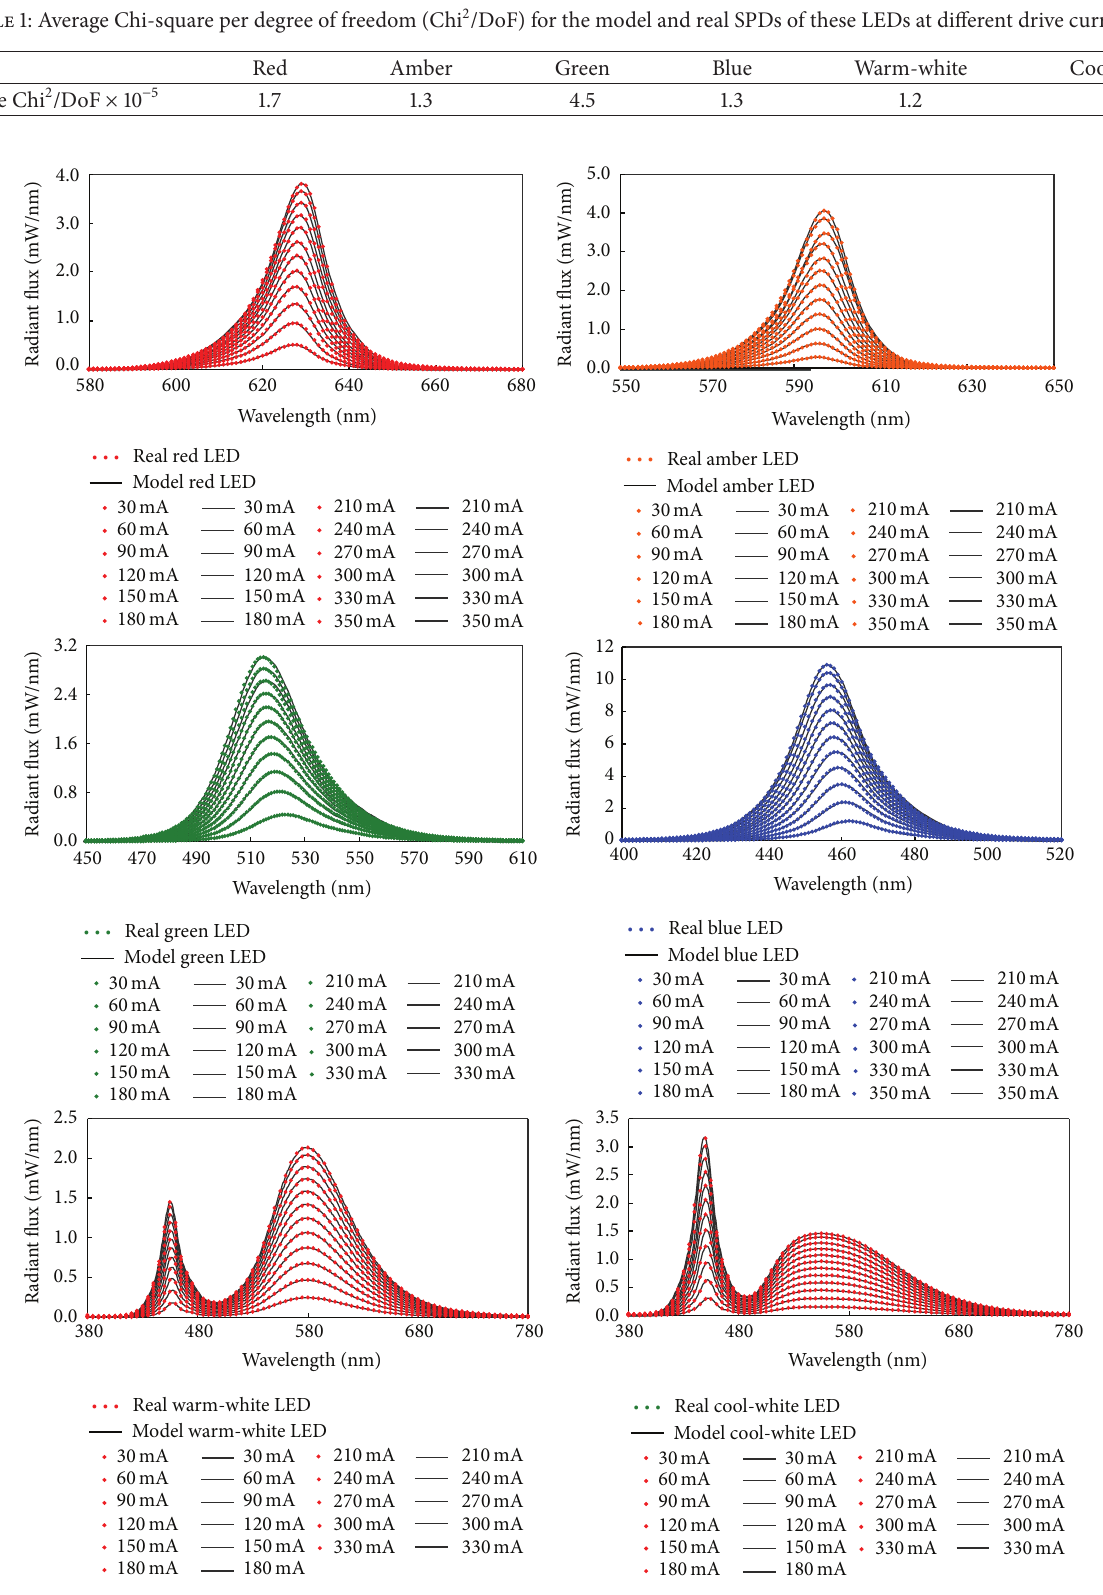
Figure 1: SPDs of model and real LEDs (red, amber, green, blue, warm-white, and cool-white) at different drive